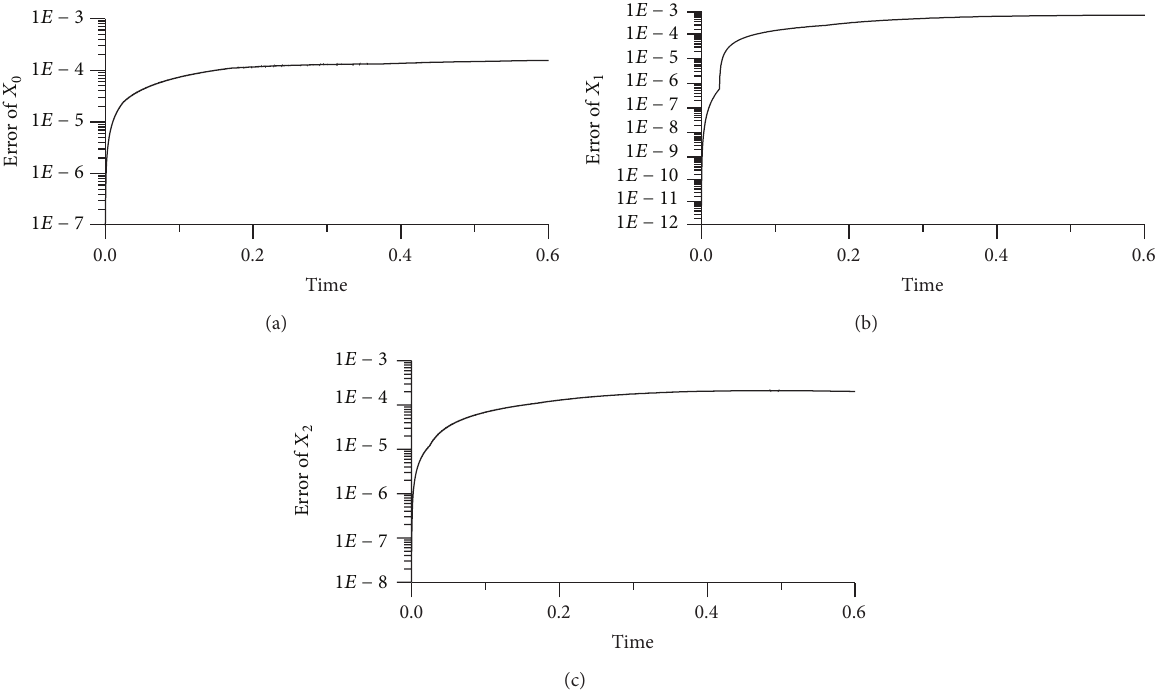
Figure 1: Error between the exact and the numerical solution provided by the single-parameter